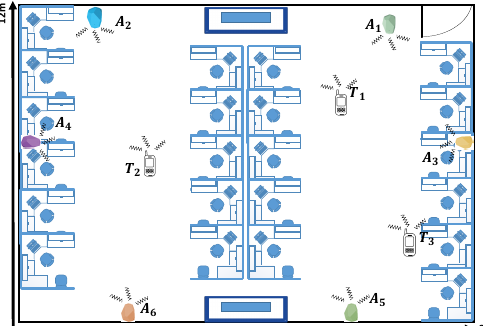
Figure 4. Environment 1: Indoor classroom that is equipped with 6 BLE estimotes used to estimate 3 tag locations.